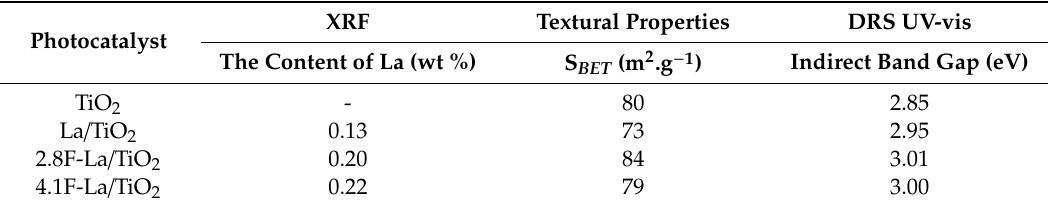
Table 1. Composition, textural, and optical properties of investigated photocatalysts.